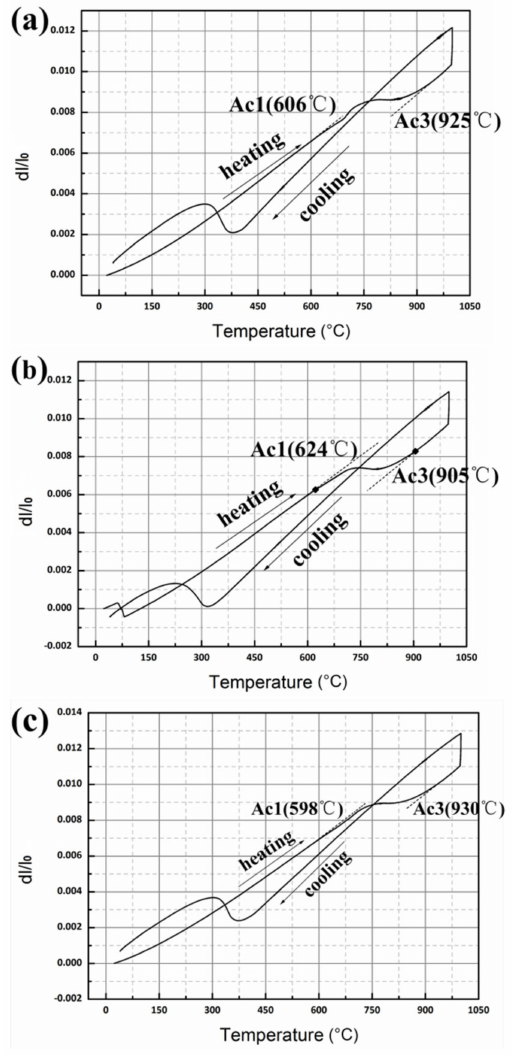
Figure 1. Dilatometric curves for the experimental steels. ( a ) 0.06C steel. ( b ) 0.15C steel. ( c ) 0.3C steel. Flat dog-bone tensile specimens with a gauge length of 25 mm and gauge width of 6 mm were machined from the sheets with the tensile axis parallel to the prior rolling direction. The tensile tests were carried out on a universal testing machine SANSCMT5000 at a constant crosshead speed of 1.5 mm min − 1 at room